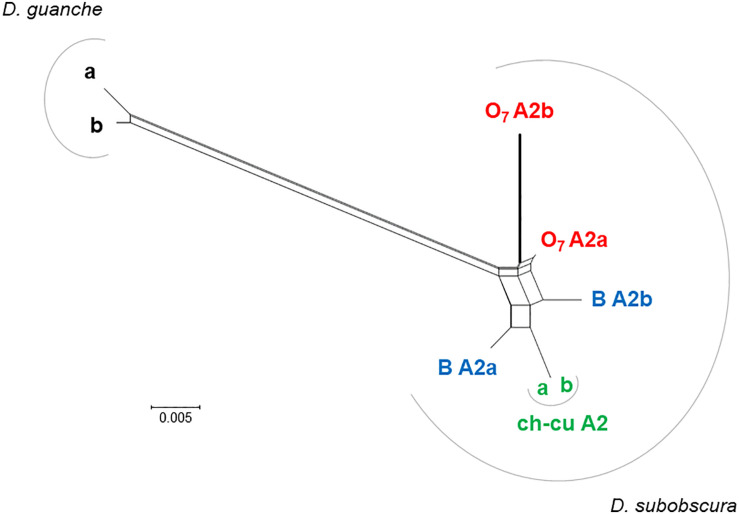
Phylogenetic network of AttA2 orthologous and paralogous sequences from the inverted (O7) and uninverted (B and ch-cu) states in D. guanche and D. subobscura. The duplication is older than the species, but the paralogs cluster within species owing to concerted evolution. Depicted thicker is the branch leading to the copy relocated by O7 (i.e., AttA2b), which is longer than that leading to the copy that remained in place (AttA2a) due to an acceleration of the synonymous substitution rate, likely as a result of having escaped concerted evolution. The split network was constructed using the NeighborNet method as implemented in SPLITSTREE version 4.14.5 (Huson and Bryant, 2006), on the JC69 + I (% of invariable sites 81.6) best-fit model distances obtained using the DIVEIN web server (https://indra.mullins.microbiol.washington.edu/DIVEIN/) (Deng et al., 2010). Sets of parallel edges represent conflicting topological signals.